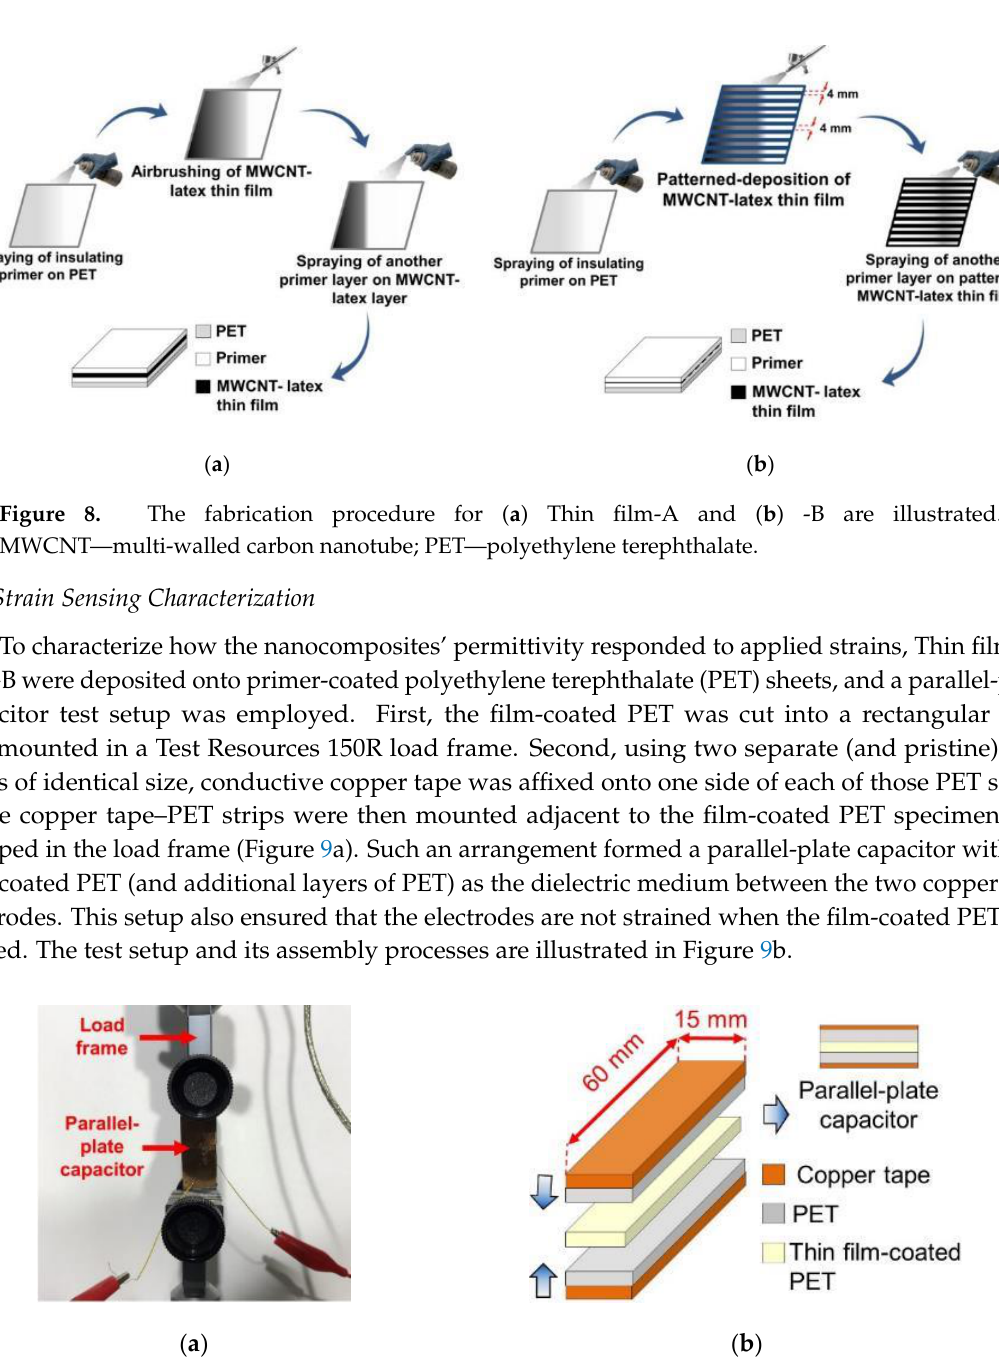
Figure 9. ( a ) A nanocomposite-coated PET strip was mounted in the load frame for characterizing its strain sensitivity. ( b ) Copper tape electrodes were used to interrogate the capacitance response of the film-coated PET.